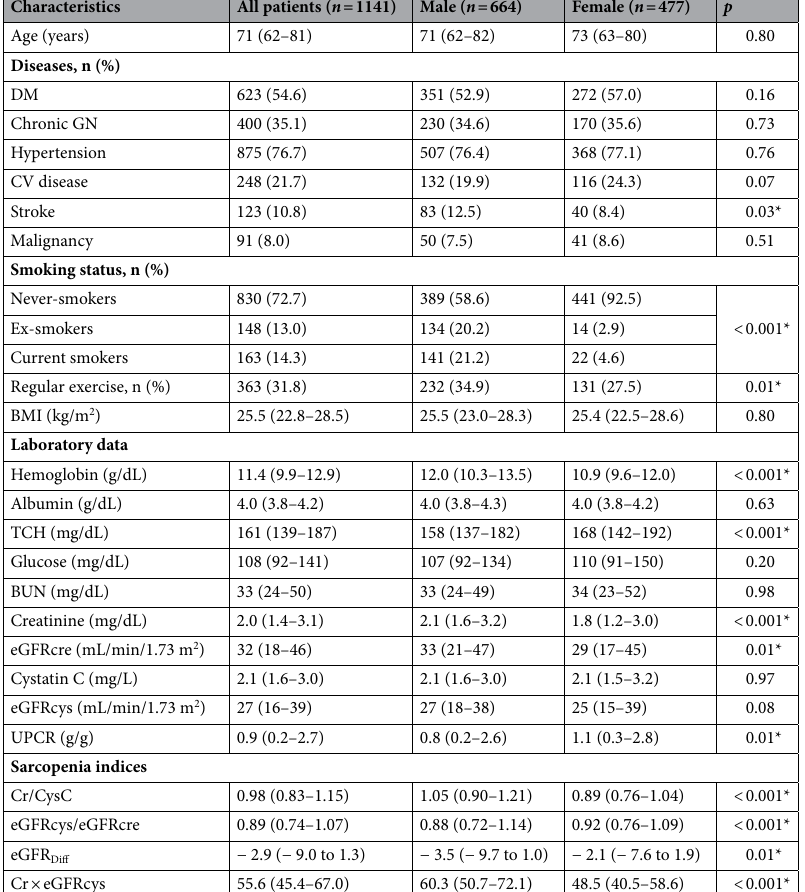
Table 1. Demographic and clinical characteristics of study population. Values for continuous variables are given as means ± standard deviations or medians and interquartile ranges. Categorical variables are expressed as numbers (%). DM diabetes mellitus, GN glomerulonephritis, CV cardiovascular, BMI body mass index, TCH total cholesterol, BUN blood urea nitrogen, eGFRcre estimated glomerular filtration rate from serum creatinine, eGFRcys estimated glomerular filtration rate from serum cystatin C, UPCR urine protein/creatinine ratio, eGFR Diff eGFRcys − eGFRcre. *p < 0.05 was considered statistically significant between male and female